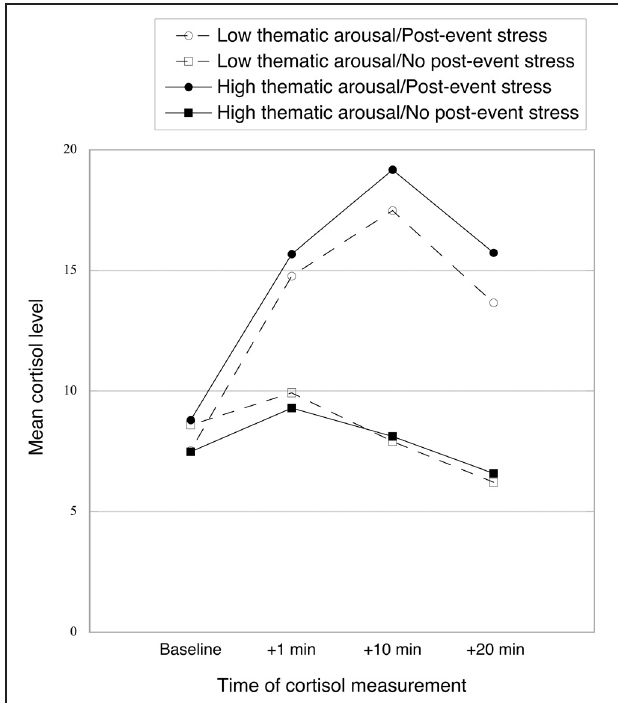
FIGURE 3 | Mean negative affect scores from PANAS (baseline and post-stress) as a function of thematic arousal and post-event stress. Higher values indicate more negative